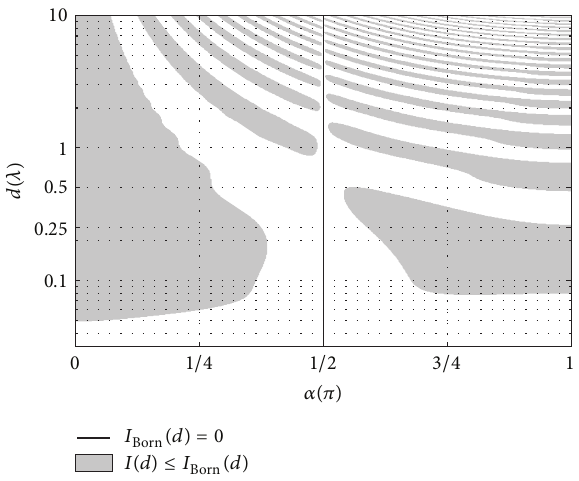
Figure5:Mapoftheregionswheremultiplescatteringeffectsdonot aid the estimation of target separation in relation to blind conditions of the Born approximation model. Black lines mark conditions (𝑑) = 0 . Gray areas mark regions where 𝐼(𝑑) ≤ 𝐼 where 𝐼 Born The same parameters are used here as in Figure 3 ( 𝜏 1 = 𝜏 2 = 1 , 𝛽 = 𝜋 − 𝛼 , 𝑑 1 is